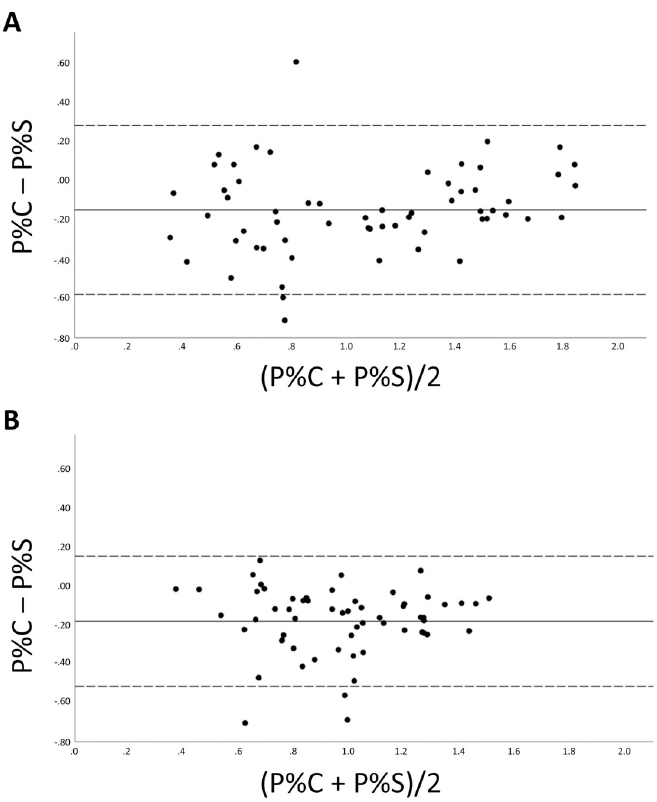
Fig 4. Bland-Altman plots evaluating the agreement between the plaque amounts obtained from images of the 3D-intraoral-scan with the plaque amounts obtained from images of the intraoral-camera; P%S and P%C after logarithmic transformation. A: upper right molar, B: lower left molar. The solid line indicates the mean difference of the methods of comparison; the broken lines indicate the 95% limits of agreement (mean ± 1.96xsd).